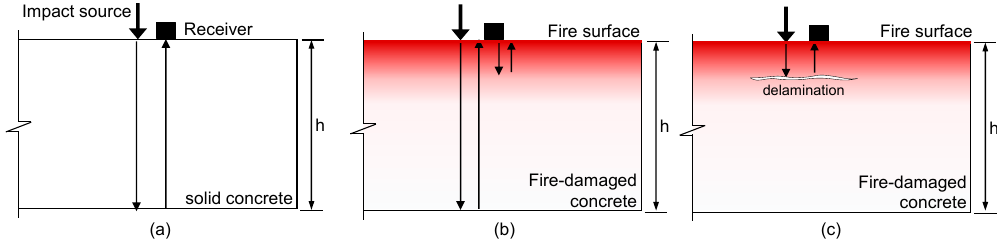
Figure 1. Illustration of the source-and-receiver configuration in IE testing: ( a ) on solid concrete, ( b ) on fire-damaged concrete without delamination defect and ( c ) on fire-damaged concrete with delamination defect.